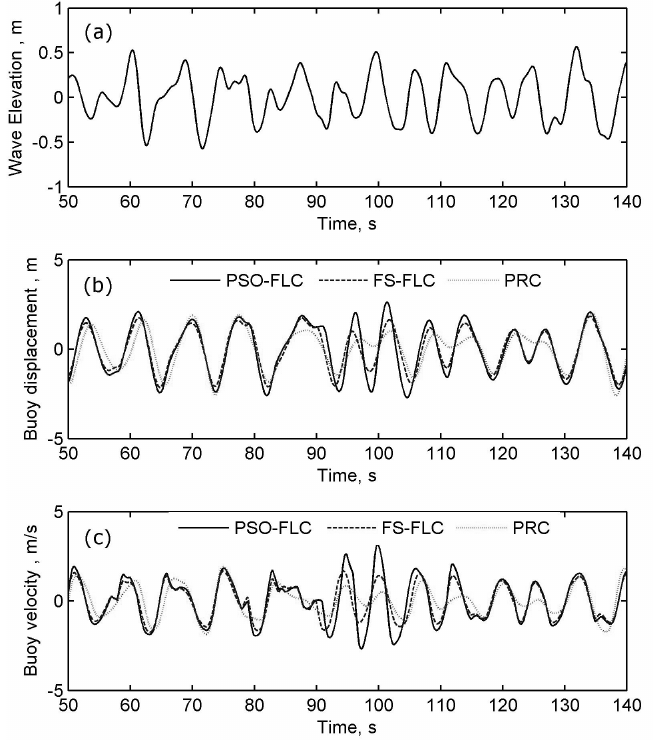
Figure 4. The dynamics of the WEC buoy under different controllers ( a ) wave elevation; ( b ) buoy displacement; ( c ) buoy velocity.